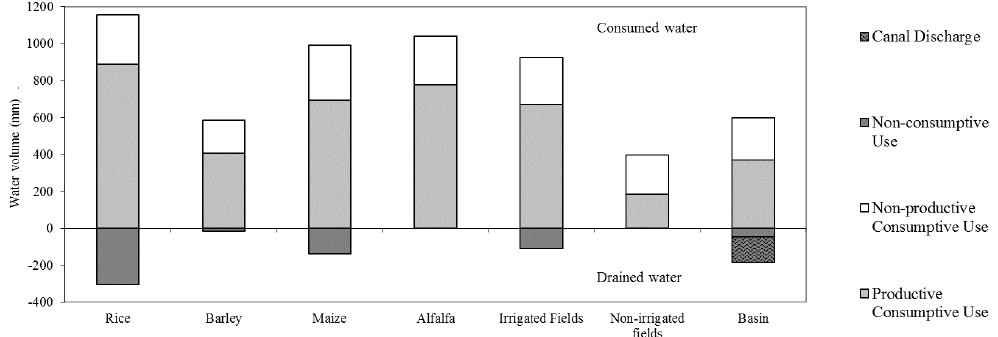
Figure 6. Water use in the Clamor Vieja basin between April 2009 and October 2010.